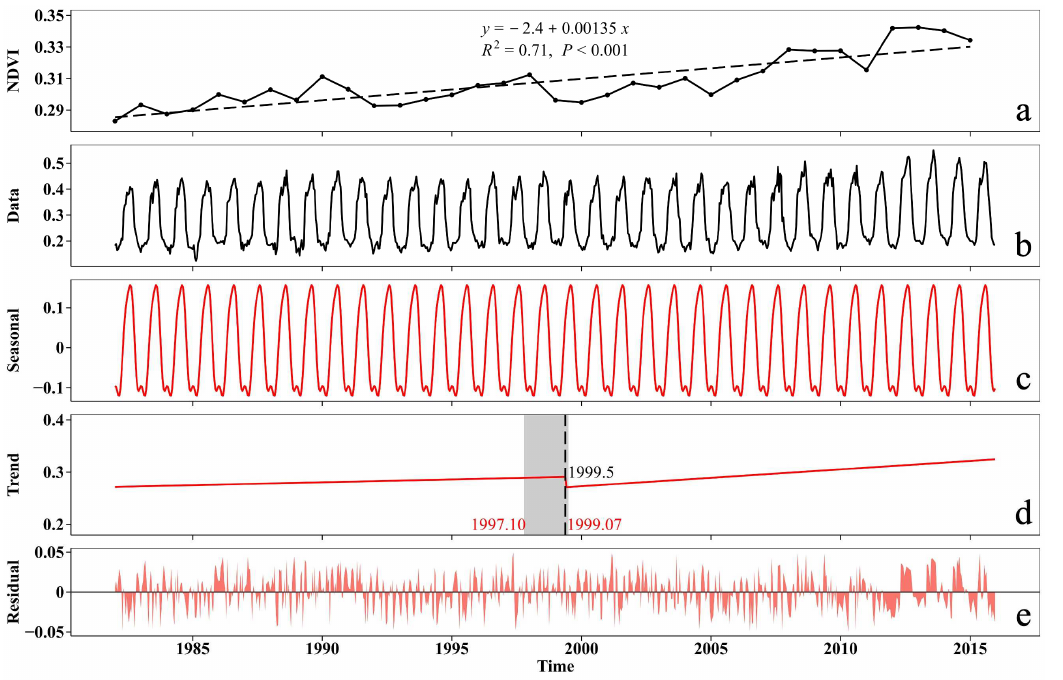
Figure 2. ( a ) Inter-annual variability of regionally averaged NDVI in the LP and ( b ) original NDVI time series, ( c ) seasonal, ( d ) trend, and ( e ) residual components of the NDVI time series decomposed by Breaks for Additive Season and Trend (BFAST). The breakpoint (BP) are black dashed lines and the confidence interval on the 0.05 level is grey-inked in the trend component.